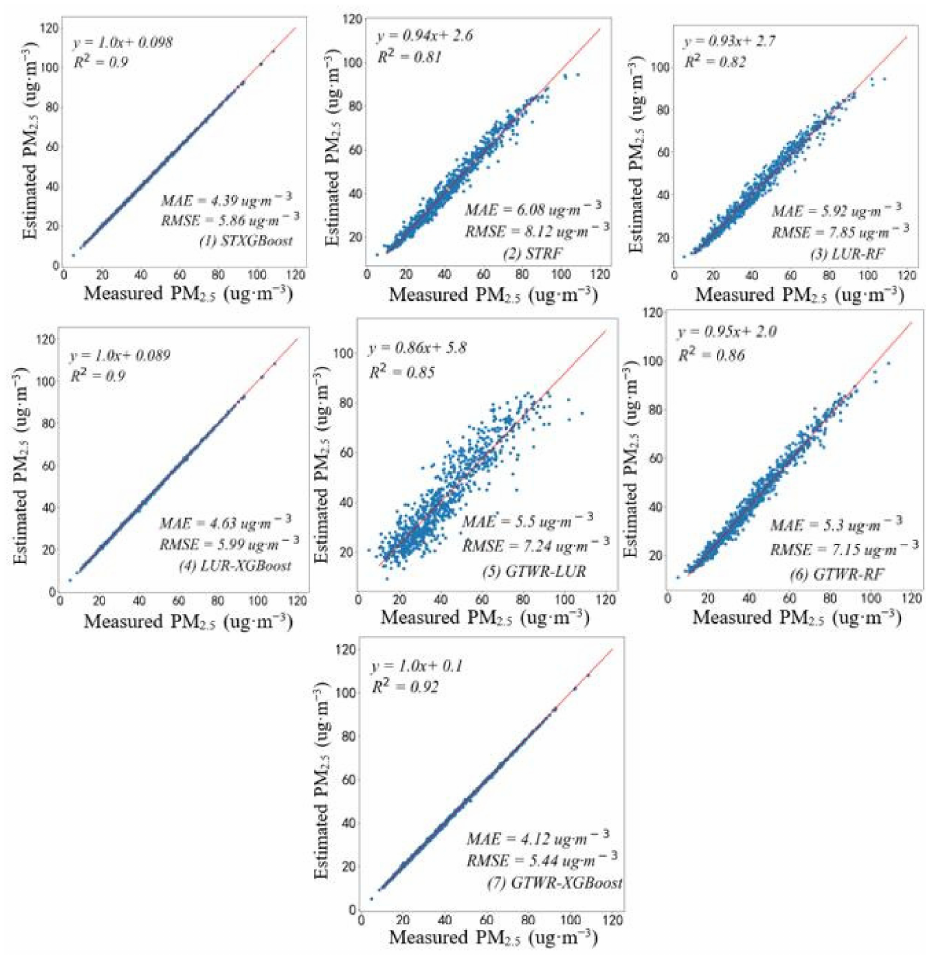
Figure 3. Scatter plot of cross-validation of each model.